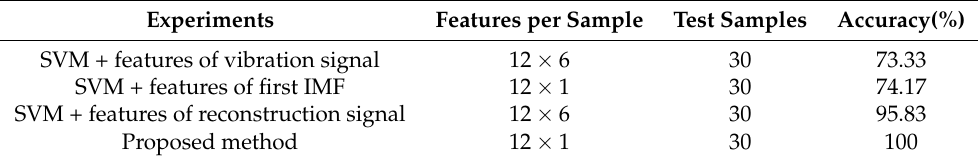
Figure 12. Test results of the support vector machine (SVM) model where the features used were extracted from ( a ) the vibration signals of six sensors; ( b ) the first IMF of six sensors; ( c ) reconstructed vibration signals using the proposed sensitive IMFs collection method; ( d ) reconstructed vibration signals using the proposed feature fusion method. Table 4. Comparison of the proposed method with commonly applied